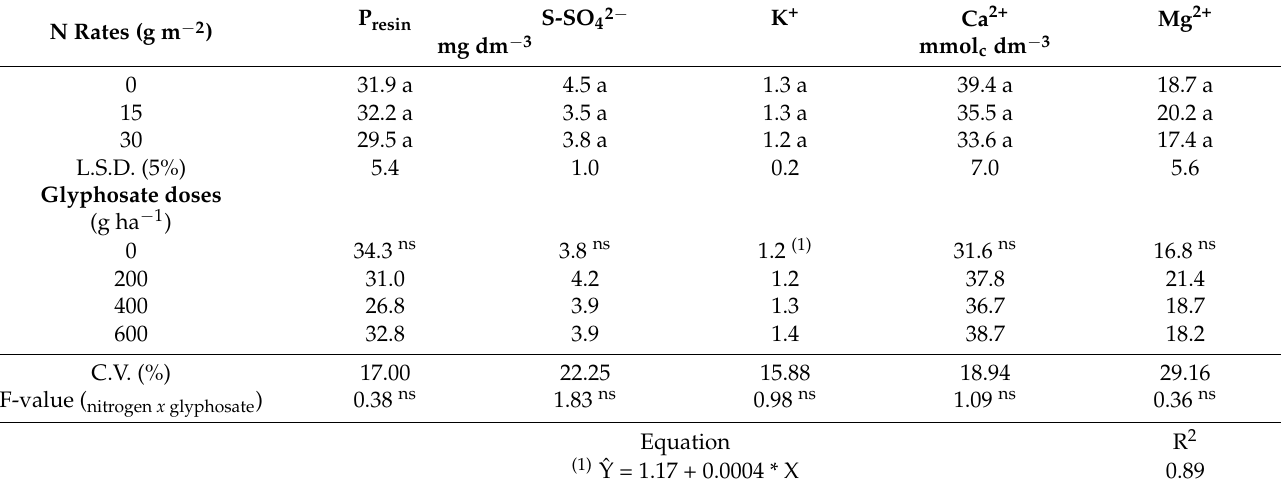
Table 5. Macronutrient contents in soil as a function of treatments with nitrogen fertilization and doses of glyphosate in emerald grass in the 10th